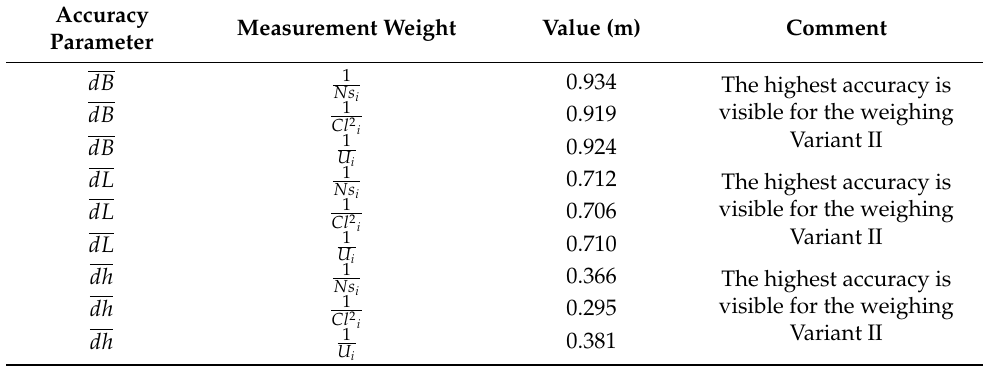
Table 6. The summary of accuracy